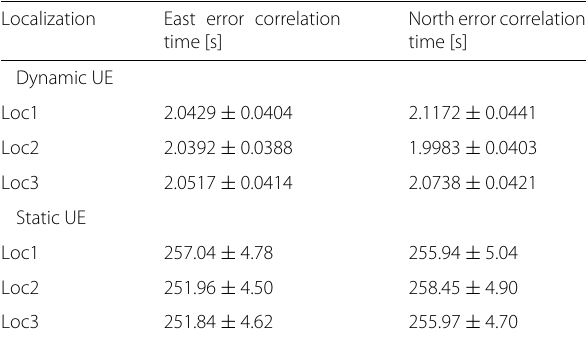
Table 4 RTK east and north localization error correlation times, averaged over 24 h with 95% confidence intervals Localization East error correlation time [s]